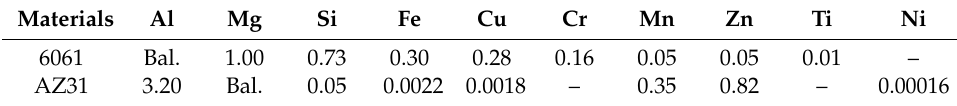
Table 1. Chemical compositions (in wt.%) of the 6061 Al and AZ31 Mg alloys.